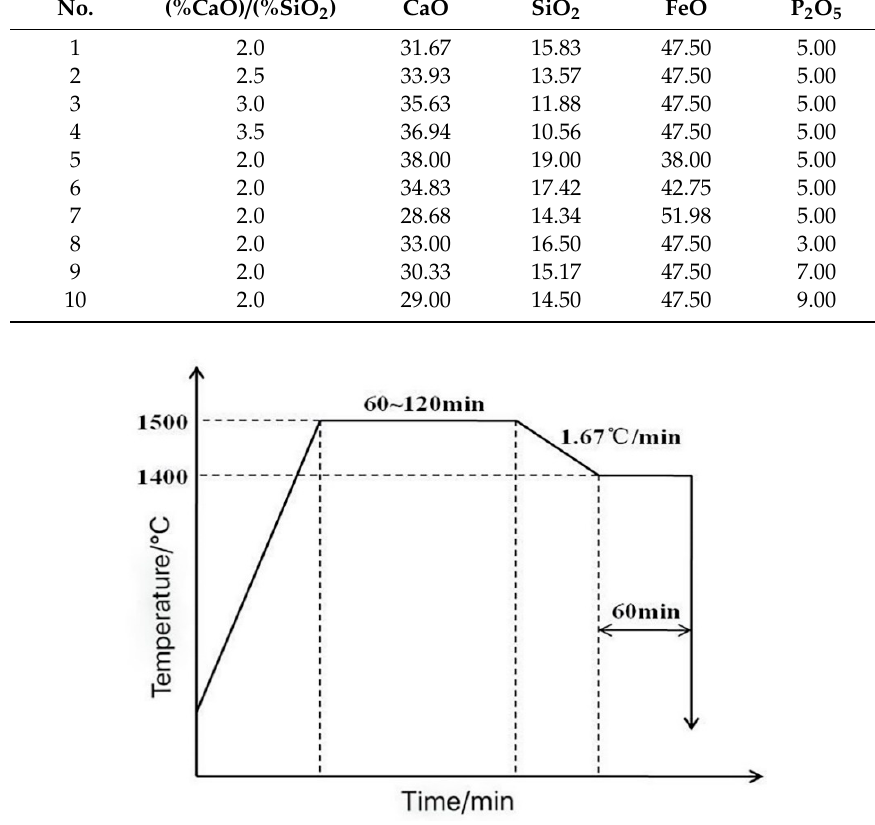
Figure 2. Temperature control curve.